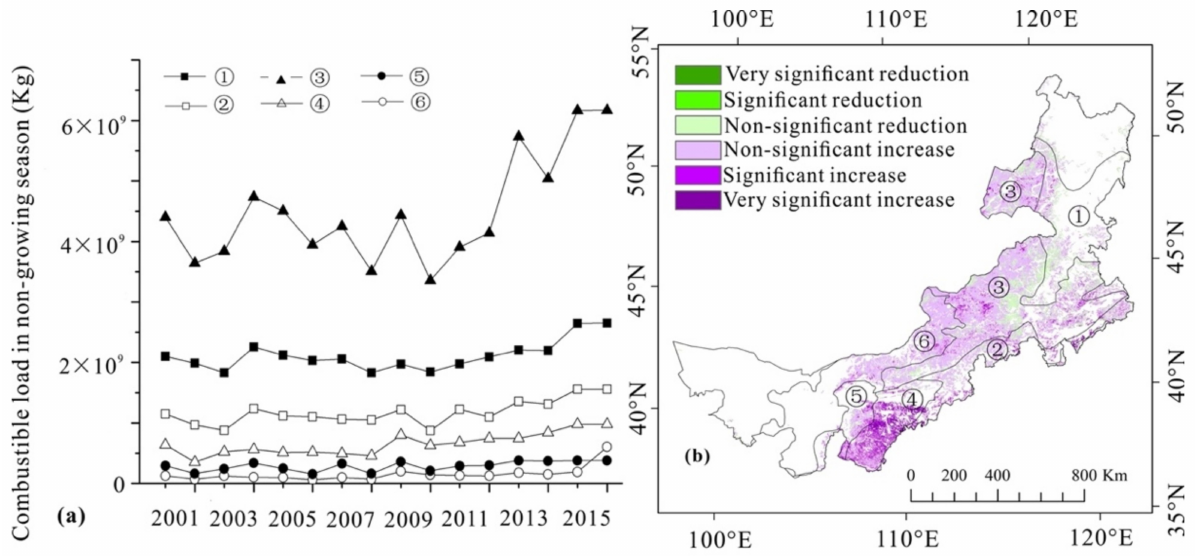
Figure 7. Statistical plots ( a ) and MK test ( b ) of combustible production of different vegetation subclasses in the nongrowing season from 2001 to 2016 (Note: 1 (cid:13) – 6 (cid:13) see Figure 1). In 2016, the nongrowing season trend of combustible load increased overall (Figure 7b), with 80.1% of the Inner Mongolia grassland region exhibiting an increasing trend of